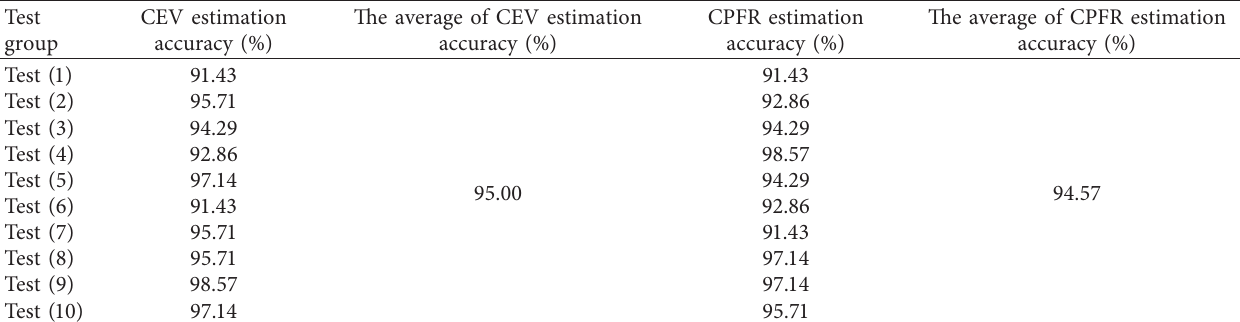
Table 4: The accuracy of ten times validations and the average values for CEV and CPFR values estimations. Test